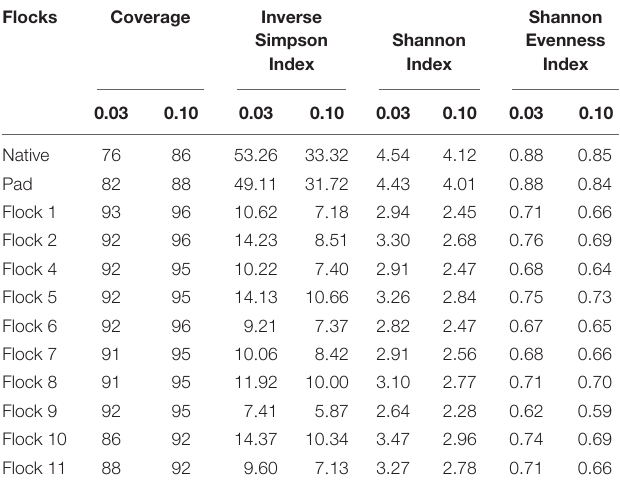
TABLE 1 | The coverage, diversity and evenness indices at 0.03 and 0.10 genetic distances of soil bacteria associated with preconstruction and subsequent flock rotations.